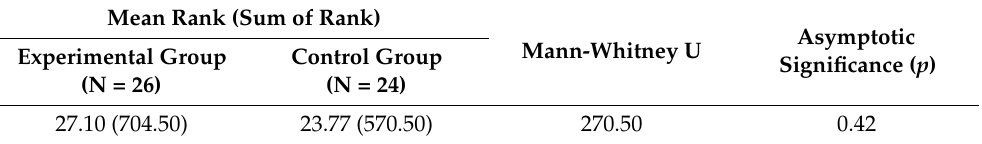
Table 3. The Mann–Whitney U test results between the two groups.